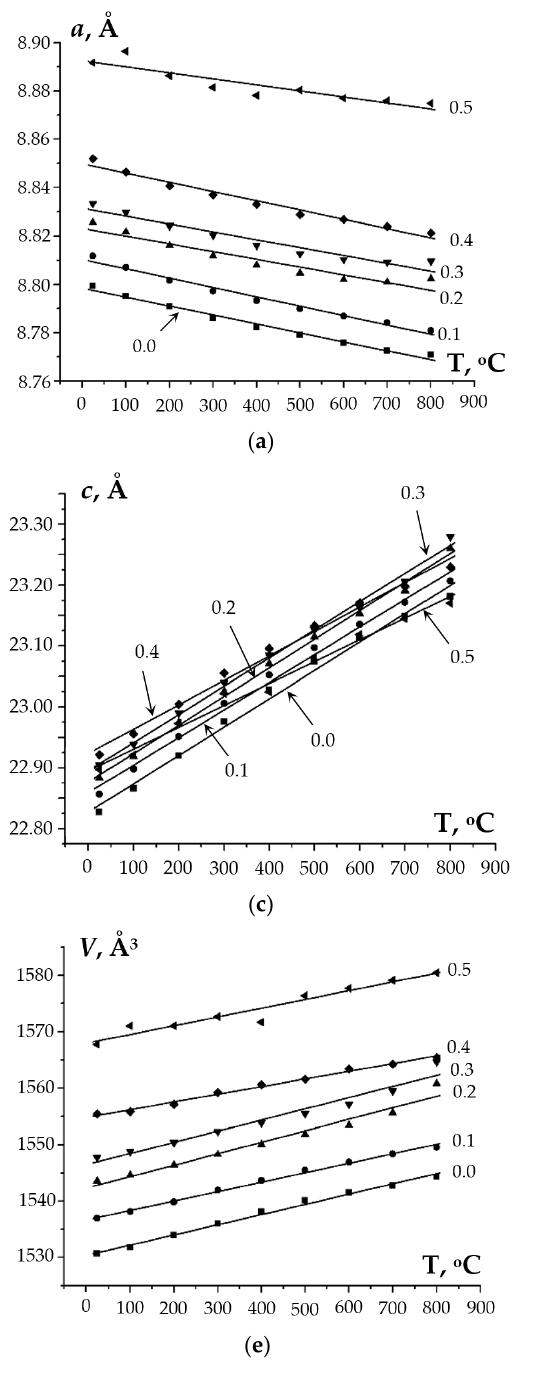
Figure 10. Temperature dependencies of the unit cell parameters a and c , and of the unit cell volume